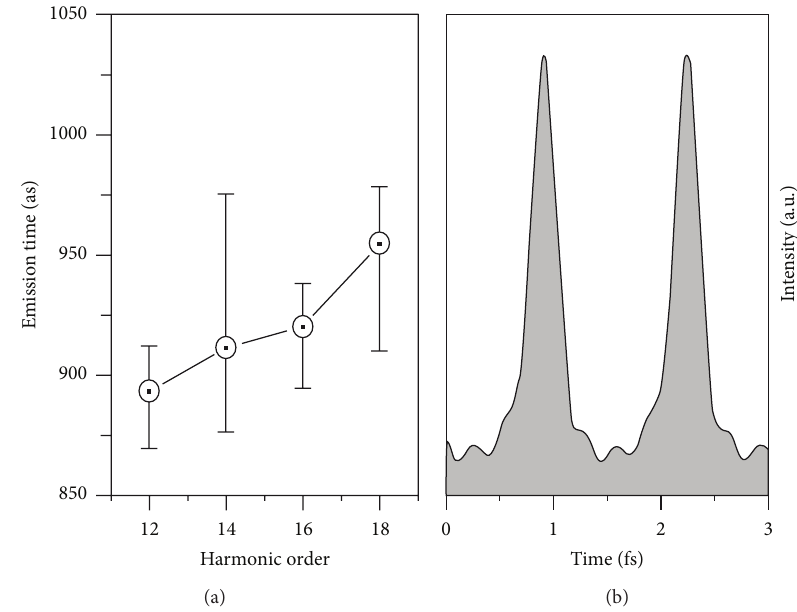
Figure 3: (a) Emission times, and (b) temporal profile corresponding to the 11th to the 19th harmonic orders [20].